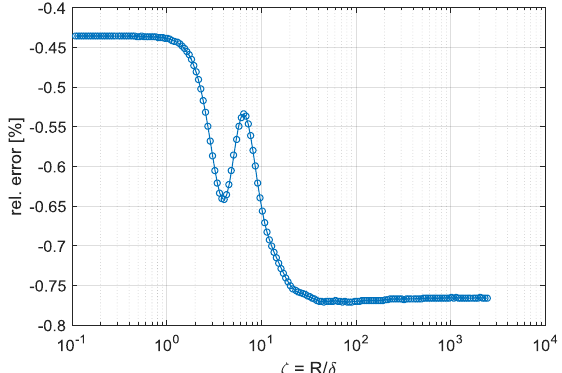
Figure 8: Semi logarithmic plot of the relative error of the approximated total inductance for 𝑙/𝑠 = 10′000 in function of the dimensionless frequency 𝜁 .